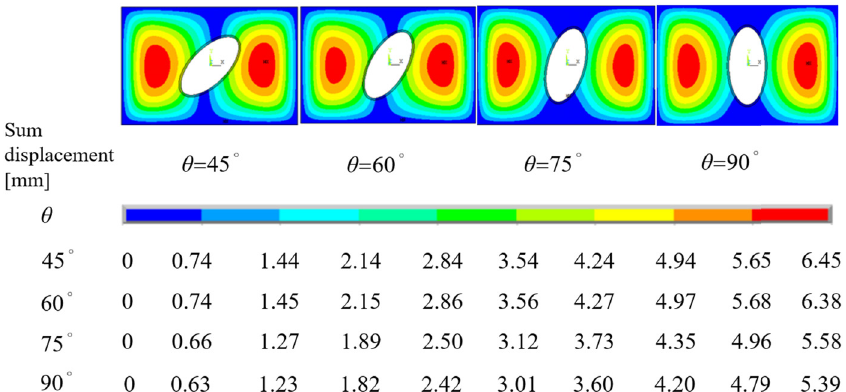
Figure 12: Displacement distribution of the perforated plates with t = 2 mm in the ultimate